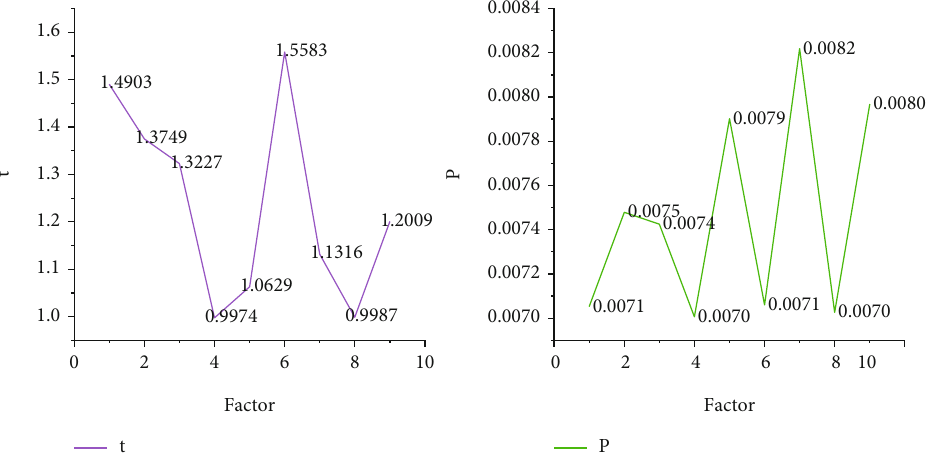
Figure 3: Comparison of t value and P value of SCL-90 assessment results before and after psychological